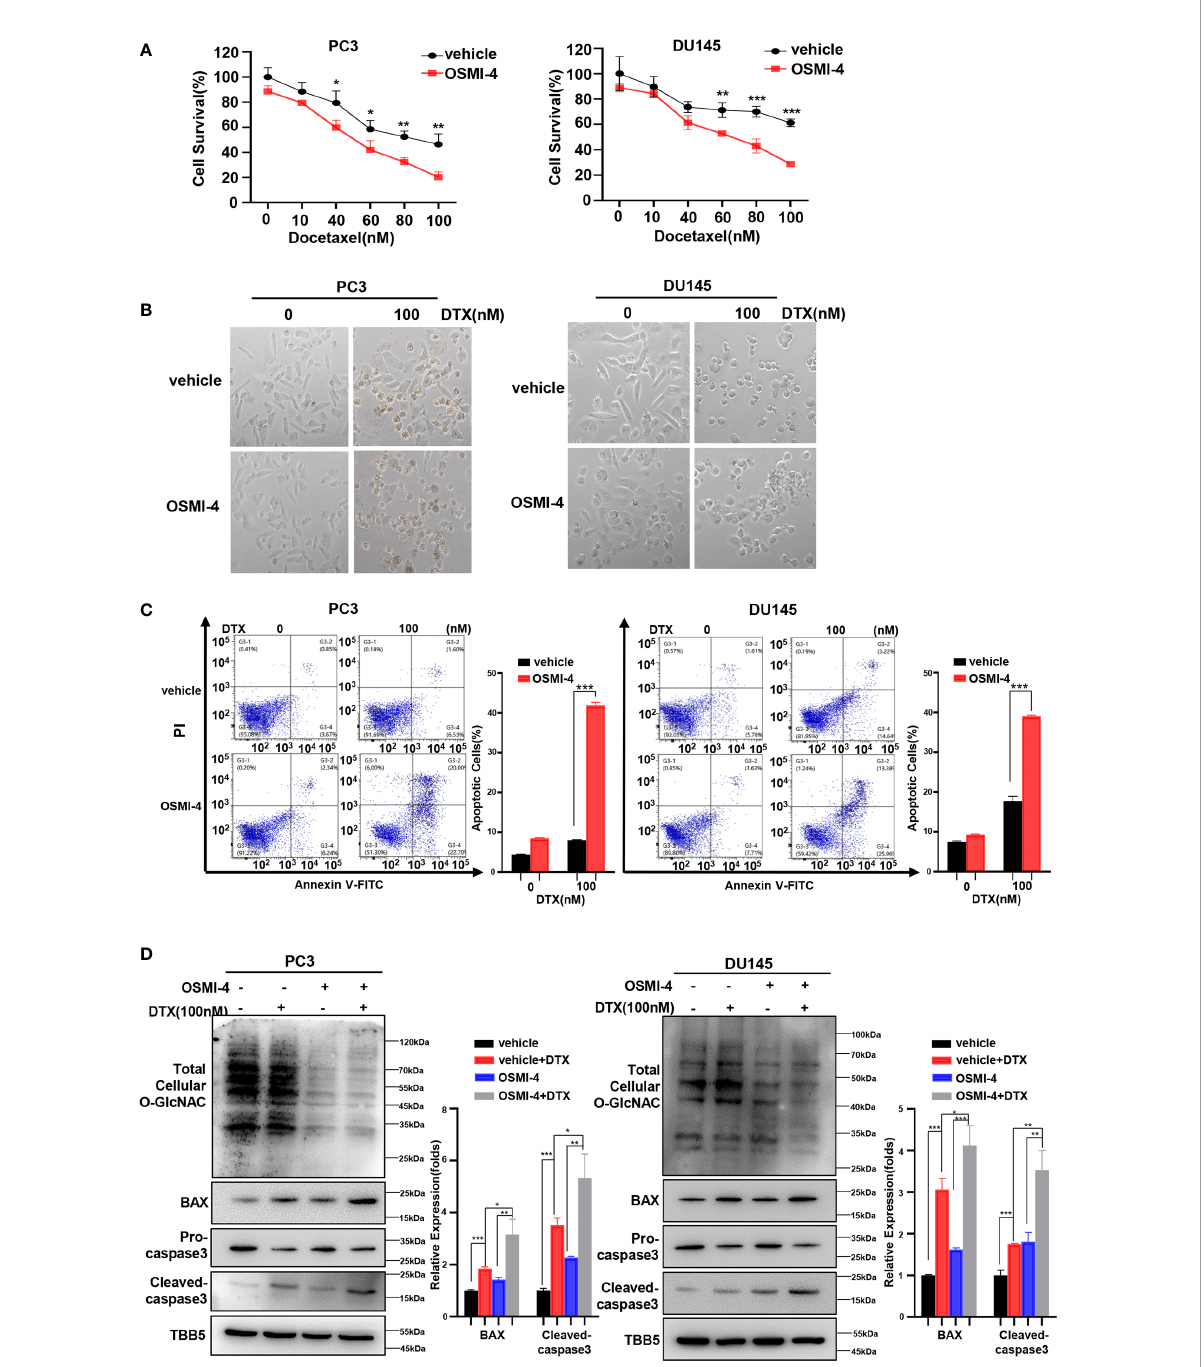
FIGURE 4 OSMI-4 inhibition of OGT sensitizes PC cells to docetaxel. (A) Cell survival analysis in PC3 and DU145 cells with different concentration of OSMI-4 treatment. (B) Morphological analysis of PC3 and DU145 cells treated with OSMI-4, compared with control group. (C) Cell apoptosis was analyzed by fl ow cytometry. (D) Treatment with OSMI-4 enhanced the expression of pro-apoptotic proteins caspase-3 and BAX, and down-regulated the O-GlcNAc levels in PC3 and DU145 cells, compared with control group. *p < 0.05; **p < 0.01; ***p < 0.001 (Student ’ s